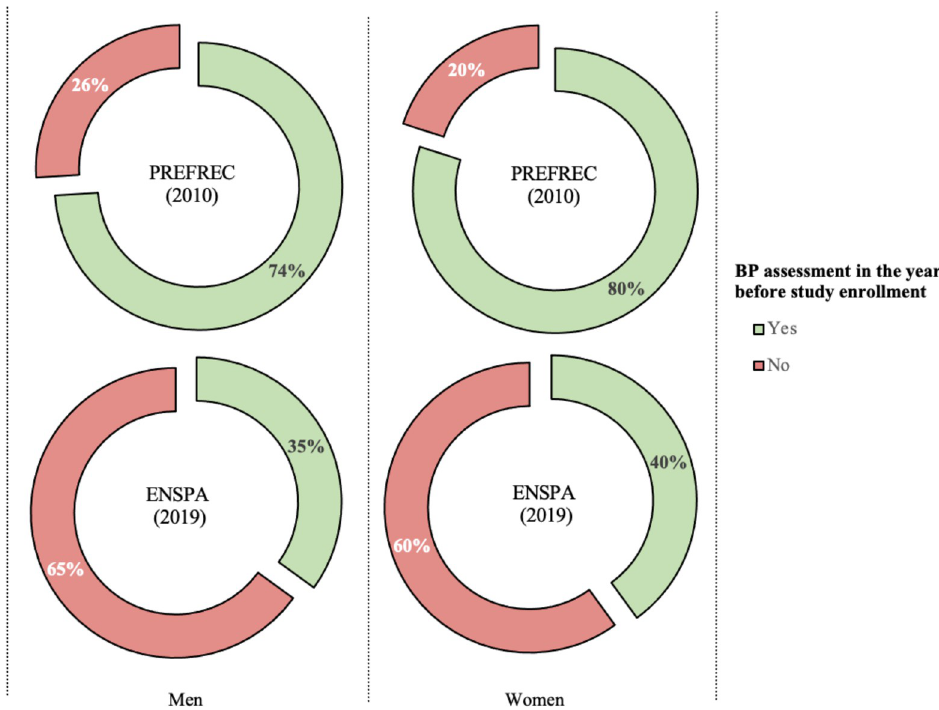
Fig 3. BP assessment in the year before study enrollment stratified by sex and the study year. BP = blood pressure. The PREFREC (2010) study: men (n = 834 [N = 255 481]), women (n = 1 899 [N = 531 326]). The ENSPA (2019) study: men (n = 1 317 [N = 666 751]), women (n = 3 334 [N = 677 584]).